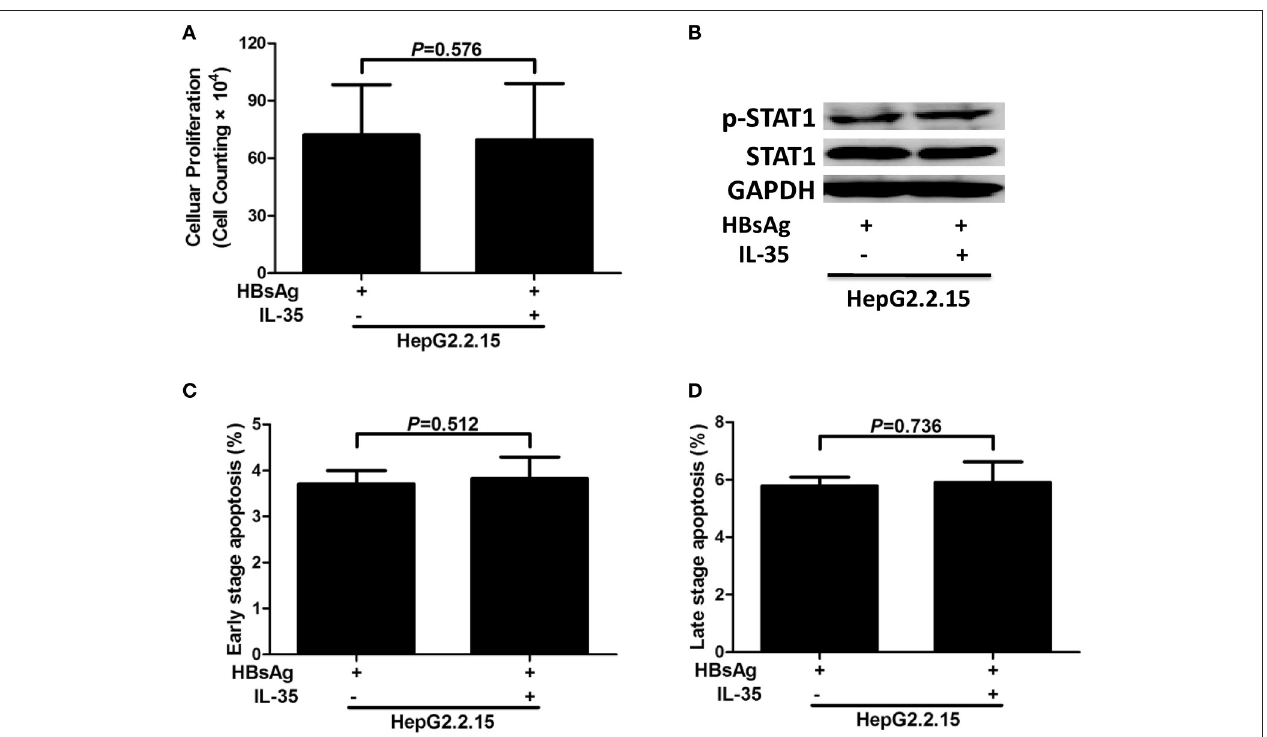
FIGURE 3 | The regulatory role of interleukin (IL)-35 in HepG2.2.15 cells. HepG2.2.15 cells were stimulated recombinant hepatitis B surface antigen (HBsAg) in the presence or absence of recombinant IL-35 for 24h, and were performed independently for five times. (A) Cellular proliferation was measured by cell counting kit-8. The data were presented as mean ± SD, and significances were calculated using paired t- test. (B) Phosphorylated STAT1 (p-STAT1) and total STAT1 were tested by Western blot, and GADPH was shown as control. The percentages of early stage apoptotic cells (C) and late stage apoptotic cells (D) were shown. The data were presented as mean ± SD, and significances were calculated using paired t-